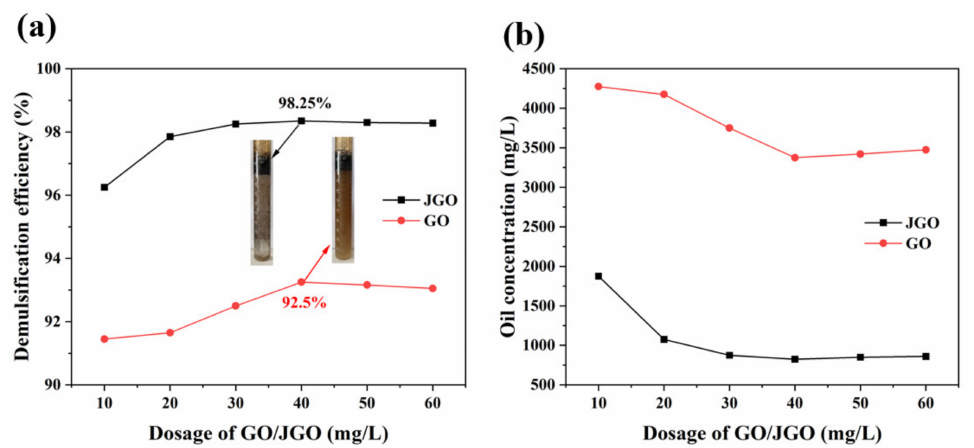
Figure 3. The demulsification efficiency ( a ) and oil concentrations ( b ) of GO and JGO with different